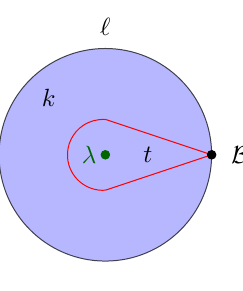
Figure 6 . Schwarzian limit of the modular S-matrix, and hence the bulk-boundary propagator. The answer is given by the expectation value of a boundary-anchored bilocal line (red line) encircling the defect (green dot). This line separates two regions with energy parameters k (region without defect) and t (region with